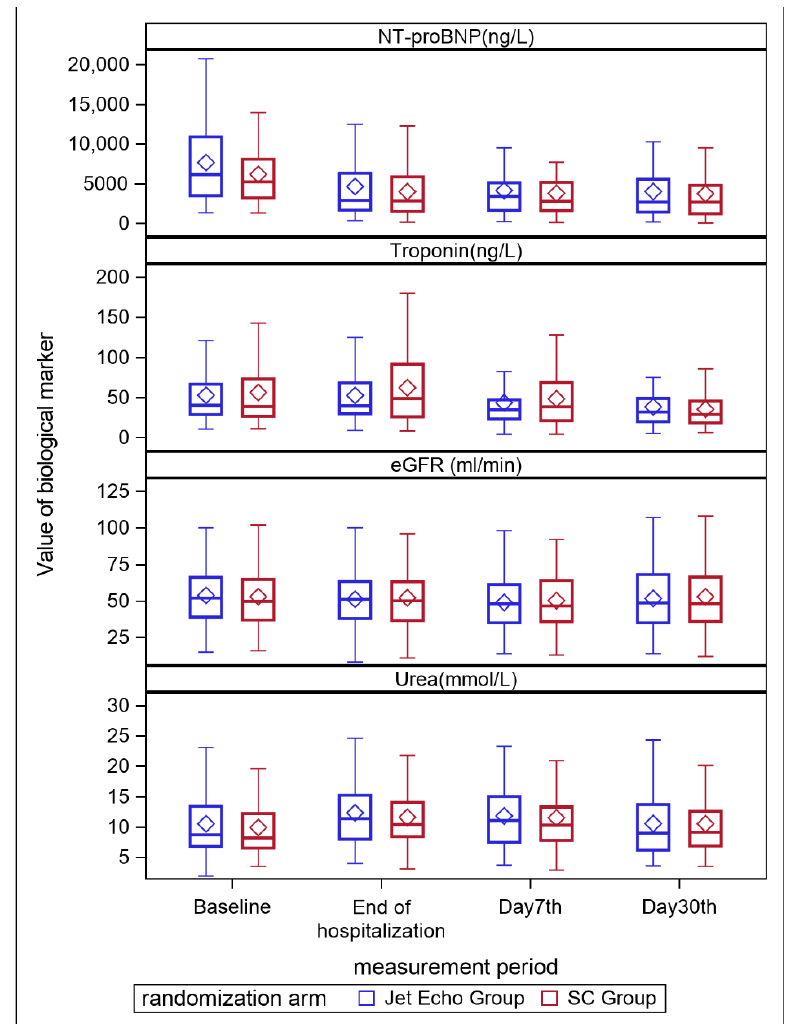
Figure 2. Evolution of biological markers at baseline, end of hospitalization, D7 and D30 after dis- charge eGFR, estimated glomerular filtration rate; Nt-proBNP, N-terminal pro-B-type natriuretic peptide.